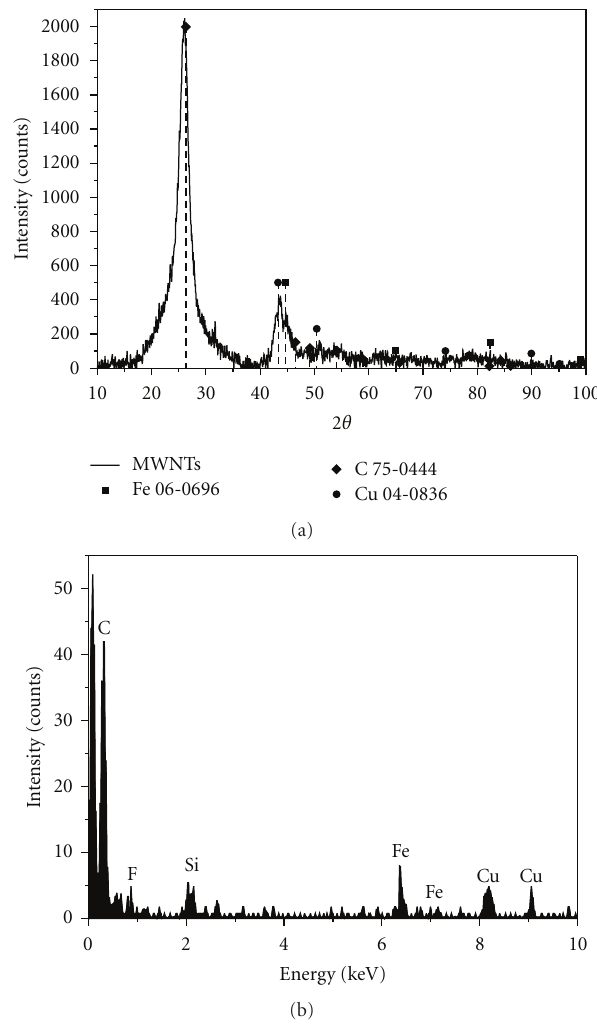
Figure 3: (a) Di ff ractogram of MWNTs indicating the correspond- ing JCPDS patterns, and (b) EDX corresponding to a point selected by